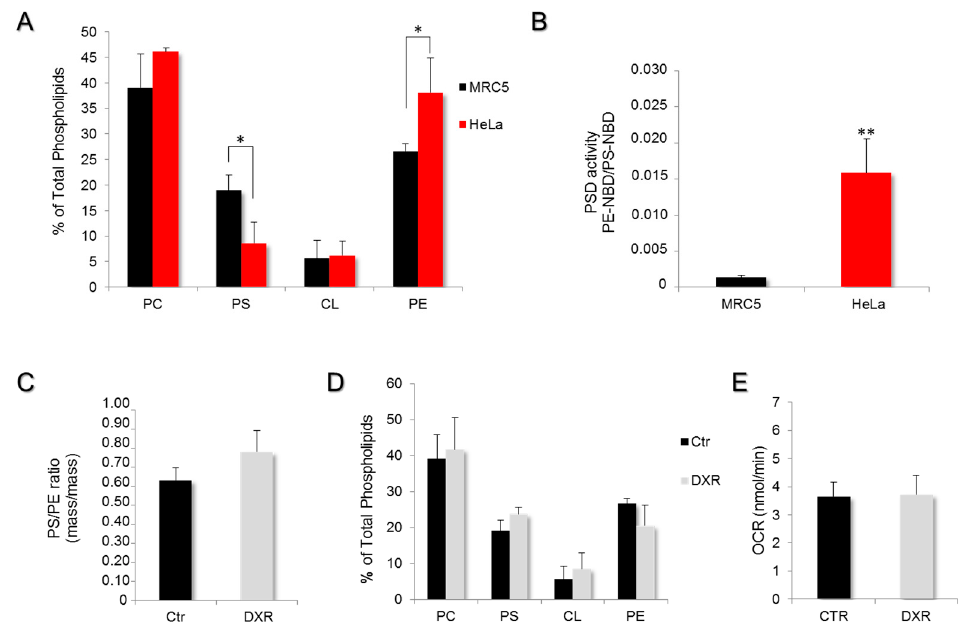
Figure 4. Phosphatidylserine decarboxylase activity is the limiting step in DXR efficiency. ( A ) The phospholipid composition of mitochondrial membranes was determined on other cells, MRC5, by high-performance thin-layer chromatography and compared to that of HeLa. The quantification of PC, PS, CL, and PE was performed by densitometry and expressed as a percentage of total phospholipids (*, P < 0.05). ( B ) PSD activity was measured on mitochondrial fractions of MRC5 and compared to those of HeLa cells. The data are expressed in PE-NBD/PS-NBD ratio per minute, as mean values ± SEM of N ≥ 3 experiments (**, P < 0.01). ( C ) The PS/PE ratio was determined in MRC5 cells treated or untreated with 5 µM DXR. ( D ) The effect of DXR on the entire mitochondrial membrane composition was assayed. DXR treatment was unable to induce a mitochondrial membrane remodeling within MCR5 cells. ( E ) The mitochondrial respiration was measured in MRC5 cells treated for 6 h with 5 µM DXR, and endogenous rates of respiration were recorded and compared to the control condition. Data are expressed as mean values of oxygen consumption rates (OCR) ± SEM, N = 5 experiments.